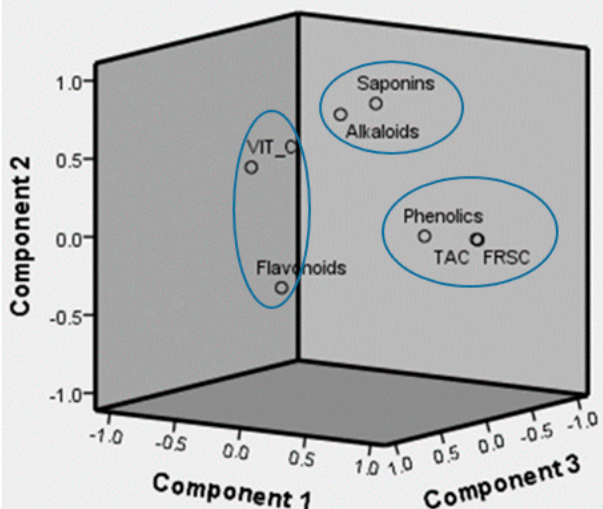
Fig. 3: Components derived from principal component analysis of Solanum anguivi Lam. fruits based on their bioactive compounds content and antioxidant activities. TAC = total antioxidant capacity, FRSC = free radical scavenging capacity, phenolics = total phenolic content, fla -